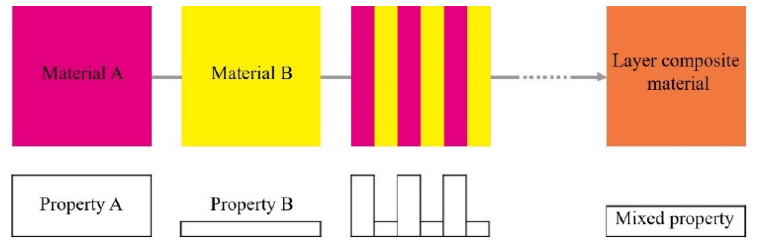
Figure 8. Layer-by-layer additive manufacturing for laminar composite structures.